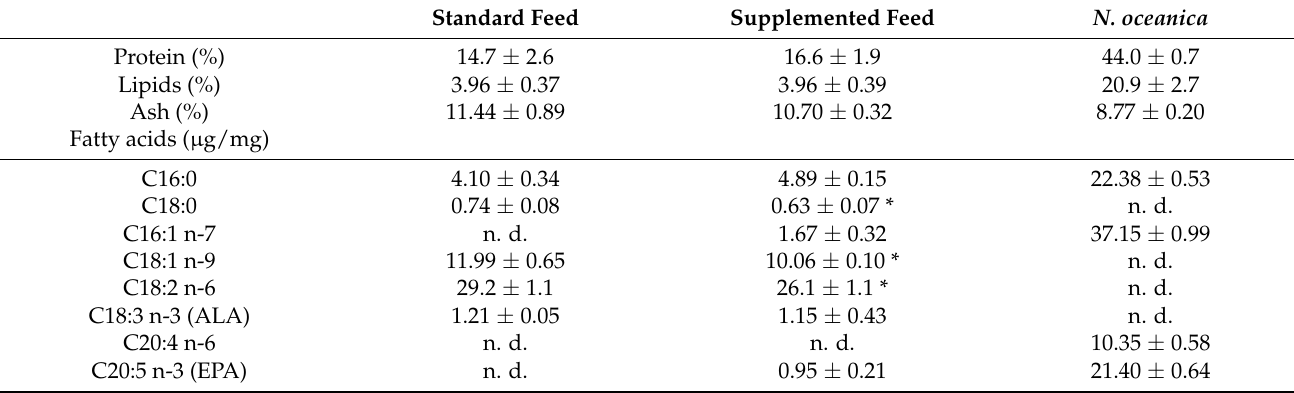
Table 1. Nutritional composition and fatty acid profile of hen feed (standard and supplemented) and of the microalgae N. oceanica . Standard Feed Supplemented Feed N.